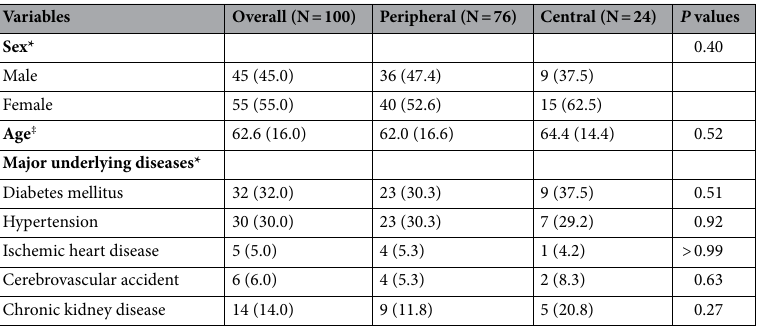
Table 1. Characteristics of the study participants (no. of procedures, N = 100). *Data in parentheses are the percentages. ‡ Data are expressed as mean (standard deviation).